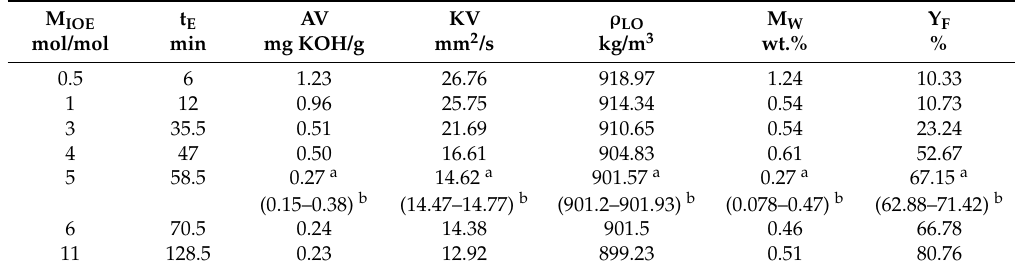
Table 1. Effects of molar ratio of IPA to oil (M IOE ) on the performance of esterification of JO by continuous addition of IPA/H 2 SO 4 (IPA/H) mixture under conditions of mass of initial oil (m O ) = 200 g, esterification temperature (T E ) = 394.2 K (393.8–394.7 K), weight percent of sulfuric acid to sum of sulfuric acid and oil (M H/HO ) = 0.94 wt.% and flow rate of IPA/H mixture (Q IPA/H ) = 1.5 mL/min. Power of ultrasonic irradiation (P UI ) = 420 W. Other notations: t E , AV, KV, ρ LO , M W , Y F = esterification time, acid value, kinematic viscosity, density of liquid or oil, water content, yield of biodiesel of fatty acid isopropyl esters